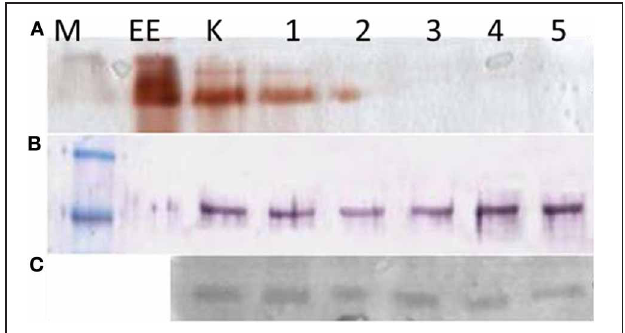
FIGURE 10 | Blood lymphocytes and monocytes isolated from buffycoats of different donors. (A) Electrophoretic revelation of ChE activity, by the Karnovsky and Roots (1964) method; (B) AChE immunoreactive molecules ( M = 82kDa). These are present in all the lanes, but inactive in the 3, 4, 5 lanes. (C) CDF/LIF ( M = ∼ 27–30kDa), the cholinergic differentiation factor expression also seems scarcely affected. M, molecular mass; EE, 15 units of electric eel AChE; K, control; 1, BW 10 − 4 M; 2, iso-Ompa 10 − 4 M; 3, chlorpyriphos 10 − 5 M; 4, chlorpyrifos oxon 10 − 5 M; 5, carbaryl 10 − 5 M.